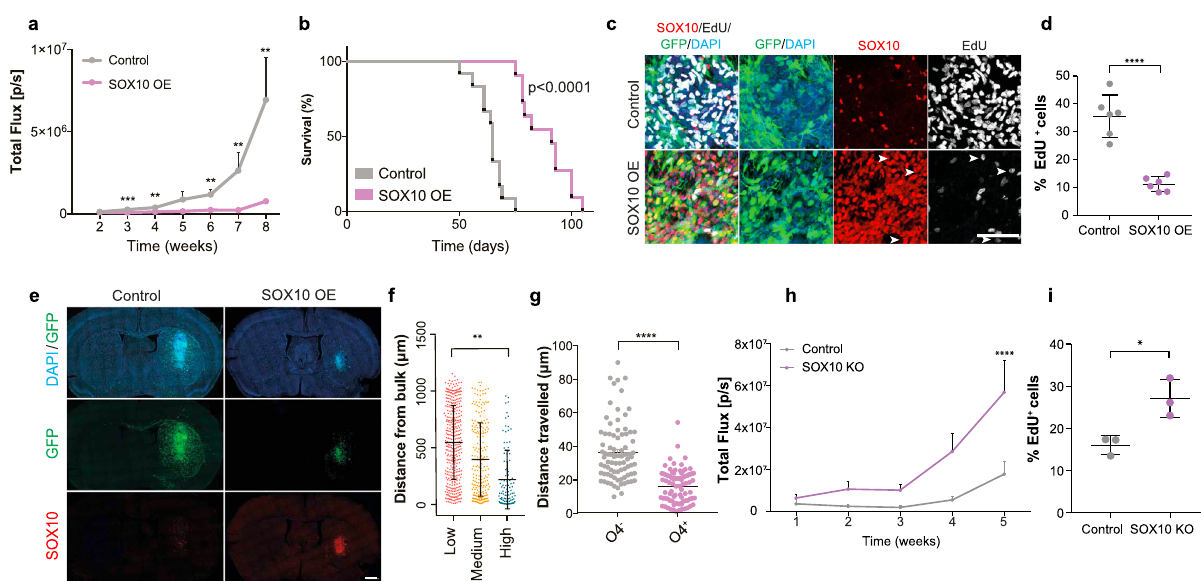
Fig. 6 SOX10 overexpression delays tumourigenesis. a quanti fi cation of luciferase bioluminescence radiance measured at the indicated time points in Control G144 and SOX10 overexpressing (SOX10 OE) xenografts. n = 12 for Control and 13 for SOX10 OE, error bars denote SEM. Unpaired two-tailed Student ’ s t test. b Kaplan Meier survival plot of mice injected with GFP + G144 Control and SOX10 OE cells. n = 8 for Control and 10 for SOX10 OE, p < 0.0001. c SOX10 (red), EdU (grey) and DAPI (blue) immuno fl uorescence staining of GFP + Control and SOX10 OE tumours at 4 weeks post-injection. Arrowheads denote EdU + cells that are negative for SOX10. Scale = 100 µ m. d % EdU + /GFP + tumour cells in Control and SOX10 OE tumours from c. ≥ 200 cells were quanti fi ed across 2 ROIs/mouse. Mean± SEM are plotted. n = 3 mice/group p = 0.0006. Unpaired two-tailed Student ’ s t test e , representative images of GFP + G144 Control and SOX10 OE tumours stained for SOX10 (red) and DAPI (blue) at 4 weeks post-injection. Scale = 1 mm. f quanti fi cation of migrated distance from tumour bulk edge of tumour cells expressing low, medium or high SOX10 levels in SOX10 OE tumours at 4 weeks post-injection. ≥ 200 cells were quanti fi ed per mouse. Each dot represents a cell. Mean ± SEM are indicated. n = 3 mice/group. One-way ANOVA. g migrated distance of O4 + and O4 − tumour cells acutely isolated from the corpus callosum region of G144 xenografts (PDX144) and cultured for 72 h in neural stem cell conditions. Each dot represents a cell, n = 90 cells/group pooled from 3 independent experiments. Median±SEM are shown. n = 3 tumours * p < 0.05. Unpaired two-tailed Student ’ s t test. h quanti fi cation of luciferase bioluminescence radiance of Control and SOX10 knock-out (SOX10 KO) PDX144 measured at the indicated time points. n = 5 Control and n = 7 SOX10 KO tumours. Mean ± SEM are indicated. Unpaired two-tailed Student ’ s t test. I % EdU + cells in Control and SOX10 KO PDX144 at 4 weeks